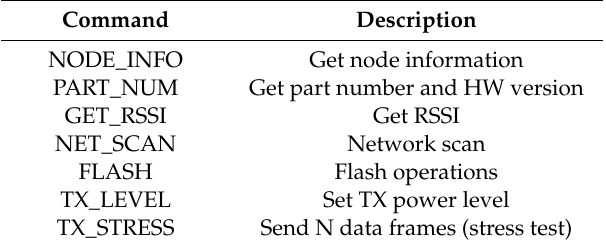
Table 2. Control Table 2. Control commands.